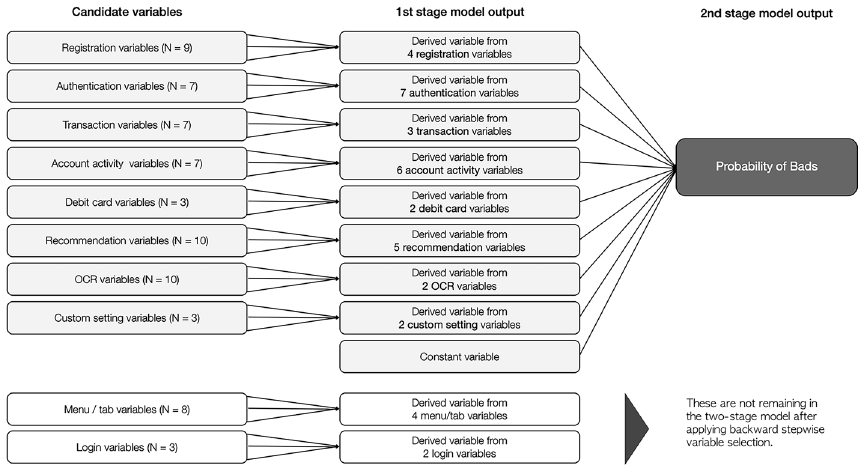
Fig. 2 Schematic diagram of the two-stage logistic regression model